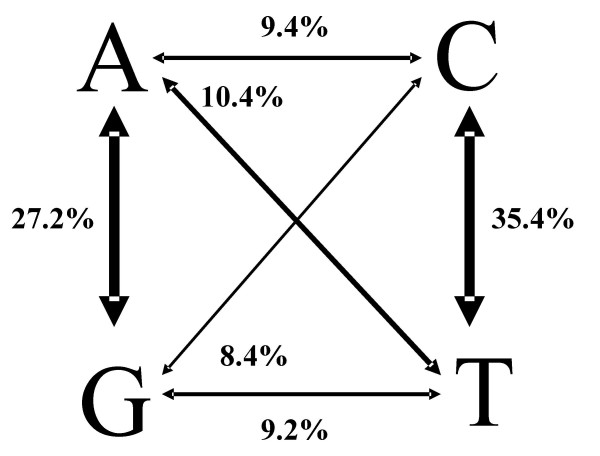
Distribution of transitions and transversions among SNPs.